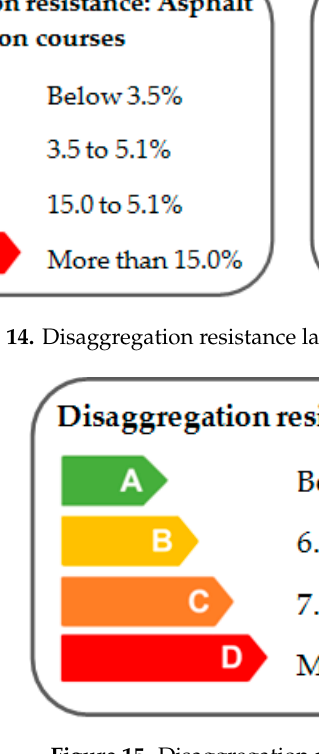
Figure 15. Disaggregation resistance global label.